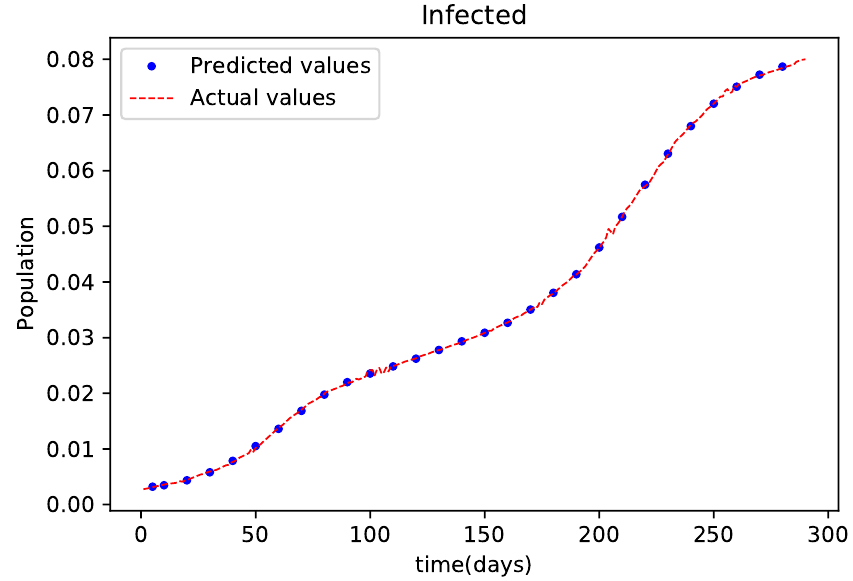
Figure 8. The graph shows a comparison of the predicted infected population values and the actual data infected population for the State of